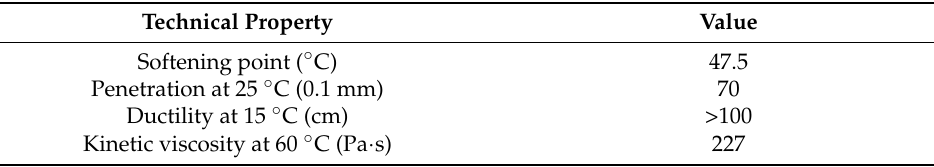
Table 1. Main technical properties of asphalt.